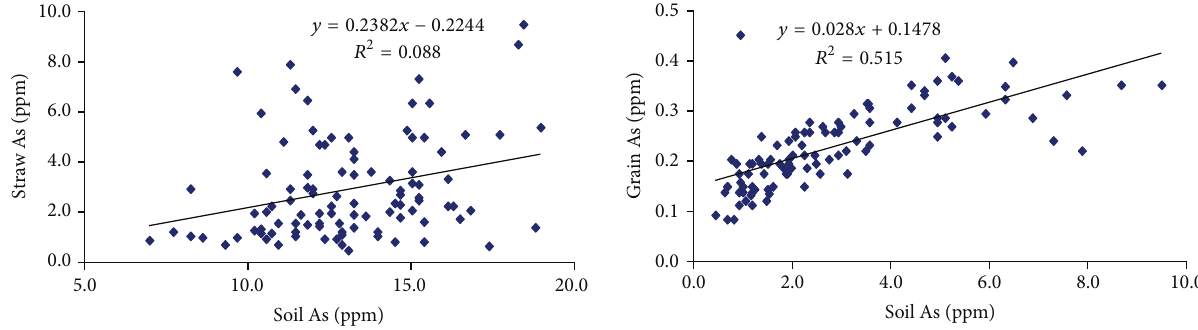
Figure 6: Relationship of soil As with straw and grain As.